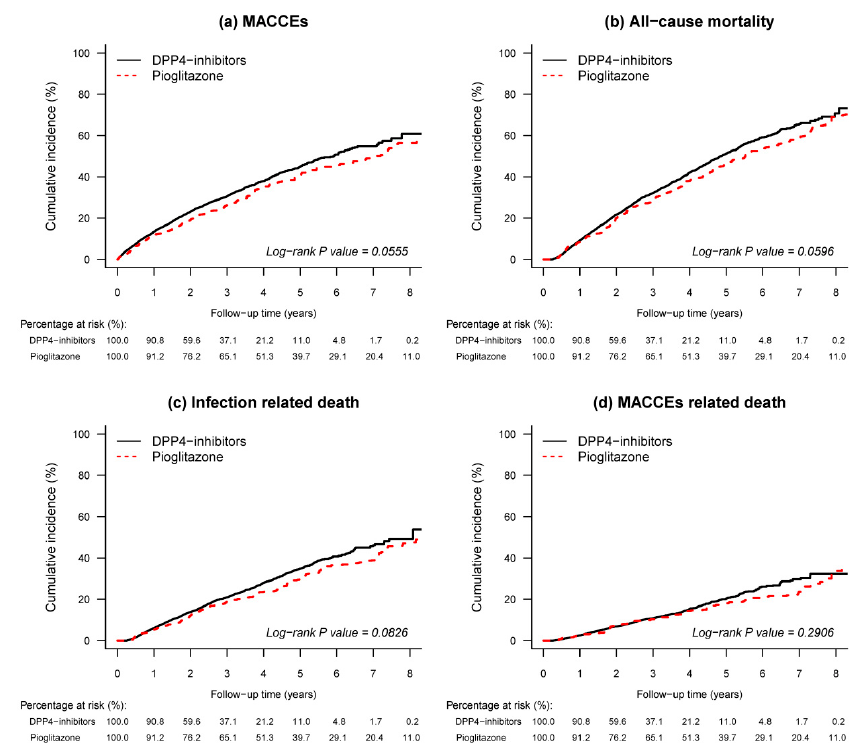
Figure 2. Kaplan–Meier curve of cumulative incidence for primary and secondary outcomes after propensity score stabilize weighting (PSSW). ( a ) Major adverse cardiac cerebrovascular events; ( b ) All-cause mortality; ( c ) Infection related death; ( d ) Major adverse cardiac cerebrovascular events